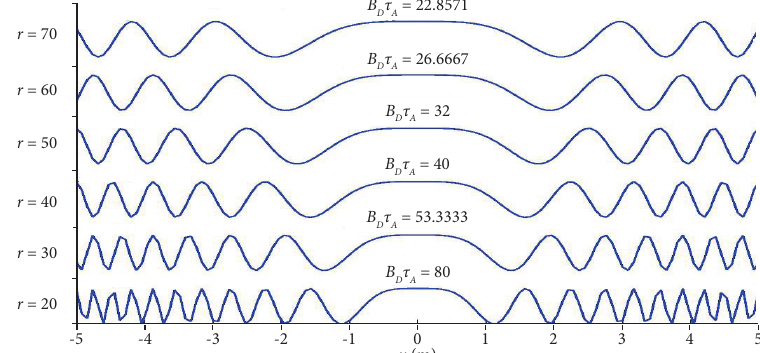
Figure 7. Azimuthal phase histories cos(2 Dƒ